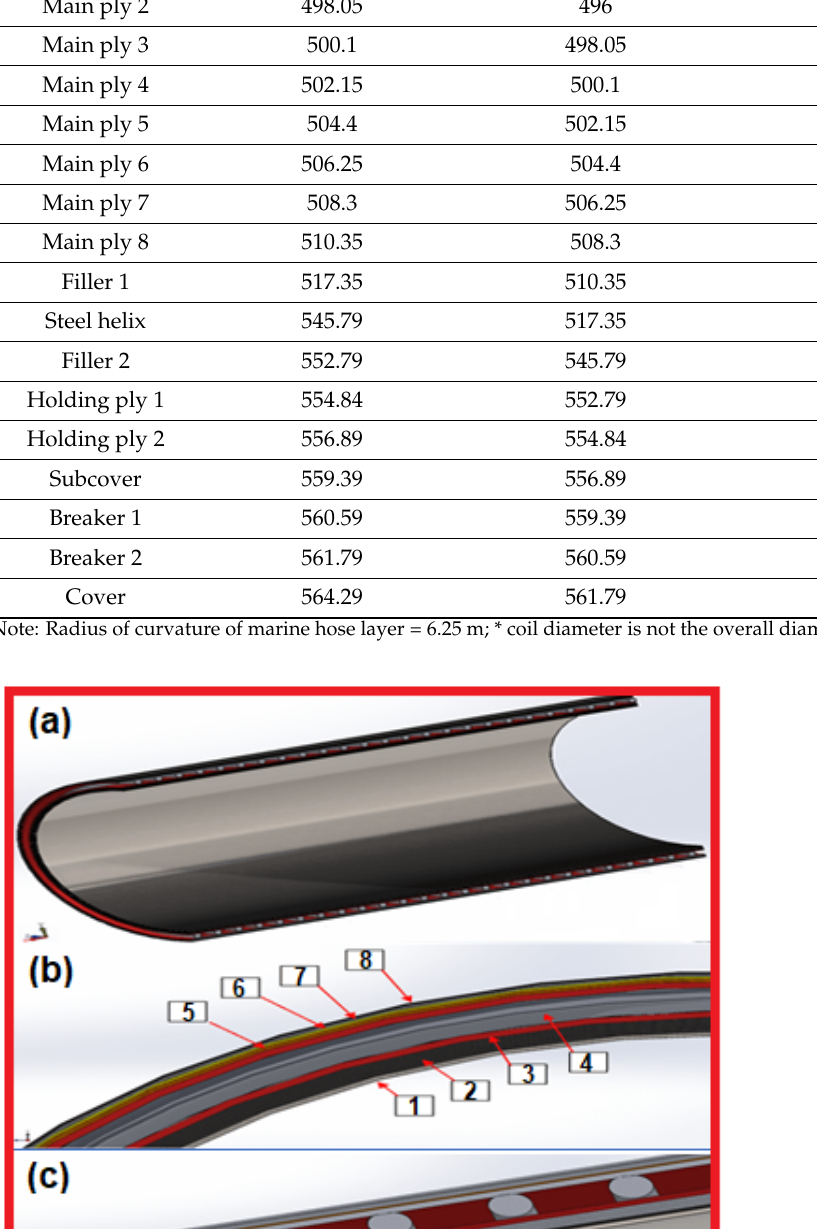
Table 3. Marine hose model dimensions .